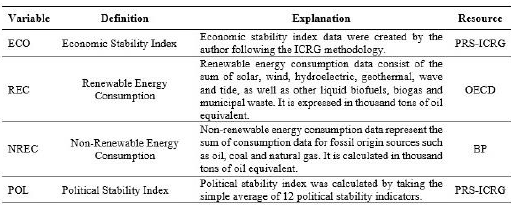
Table 1: General Explanations of Variables